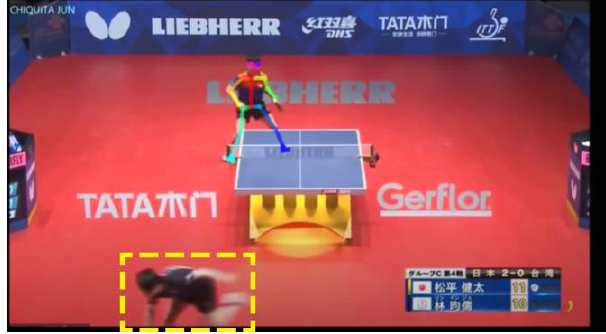
Figure 6. Some postures may not be recognized correctly.